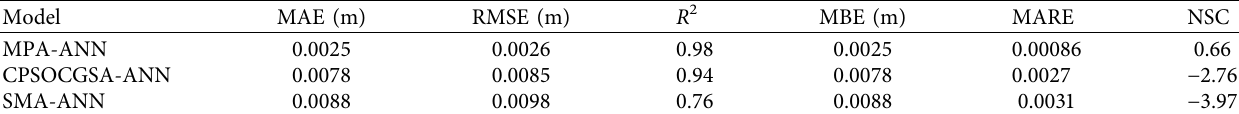
Table 4: Performance assessment for validation data